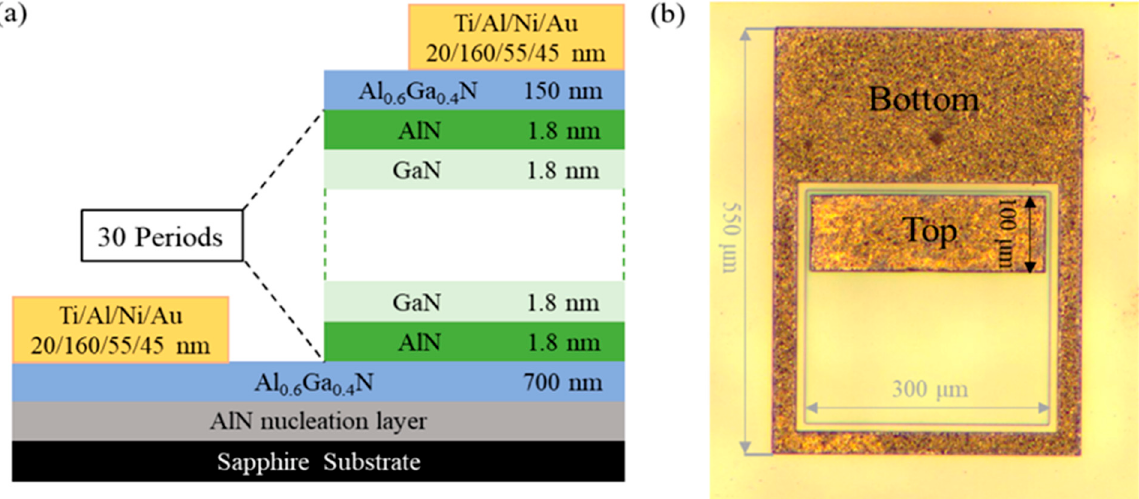
Figure 1. ( a ) Structure diagram of the GaN/AlN multi-quantum wells infrared detector. The omitted part is 30-periods GaN/AlN quantum wells starting and ending with the AlN layer. The Si atom doping concentration of GaN wells layer is 1 × 10 15 cm − 3 , and the Si atom doping concentration of top and bottom Al 0.6 Ga 0.4 N contact layer is 5 × 10 19 cm − 3 . ( b ) Physical picture of the GaN/AlN multi-quantum wells infrared detector. The outer layer is the bottom electrode of the device, and the middle is the top electrode of the device.